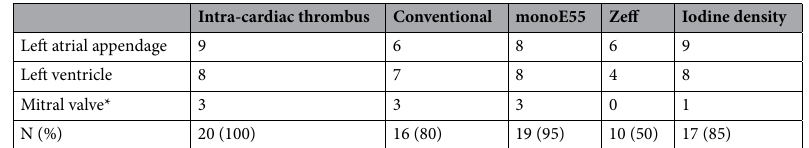
Intra-cardiac thrombus Conventional monoE55